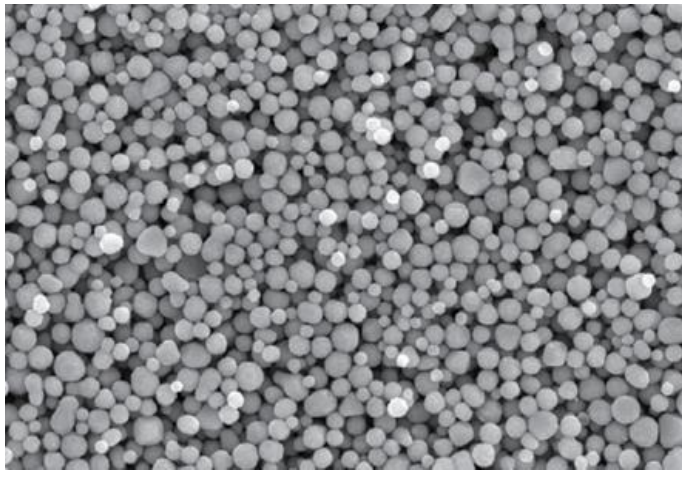
Figure 1. Ultrafine nickel powder with a grain diameter of 0.2 µm [38].